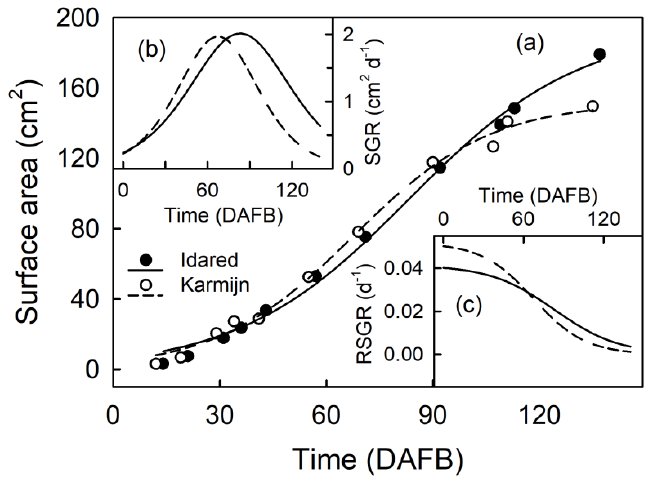
Figure 1. Time courses of change in fruit surface area of developing ‘Karmijn’ and ‘Idared’ apples ( a ). Fruit surface area growth rate (SGR; b ) and relative fruit surface area growth rate (RSGR; c ) as affected by time. Data represent means ± SE. The minimum number of replicates was 40 fruit. Error bars are not visible, as they are smaller than the data symbols. DAFB = days after full bloom. The number of epidermal cells (EC) and hypodermal cells (HC) per fruit increased with time but at a decreasing rate. Both cell numbers were higher in Idared than in Karmijn (Figure 2a,b). At the same time, the numbers of EC and HC per unit surface area decreased. Numbers were always higher in Idared than in Karmijn (Figure 2c,d).